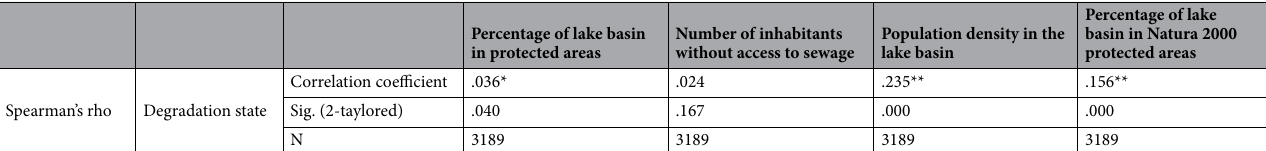
Table 3. The results of the statistical analysis regarding the relationship between the state of degradation and variables within the river basin. *Correlation is significant at the 0.05 level (2-tailed), **Correlation is significant at the 0.01 level